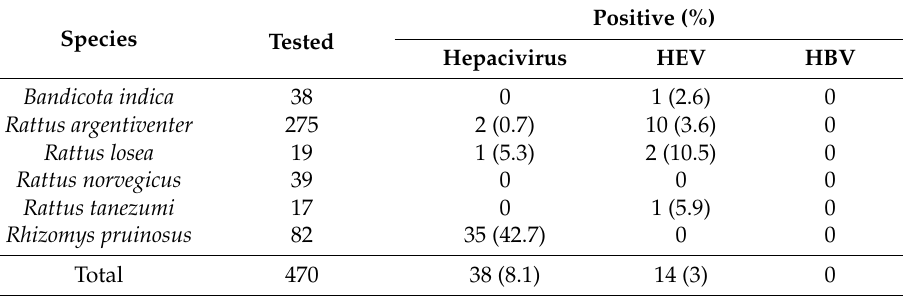
Table 1. Detection of hepatitis related viruses in rodent liver